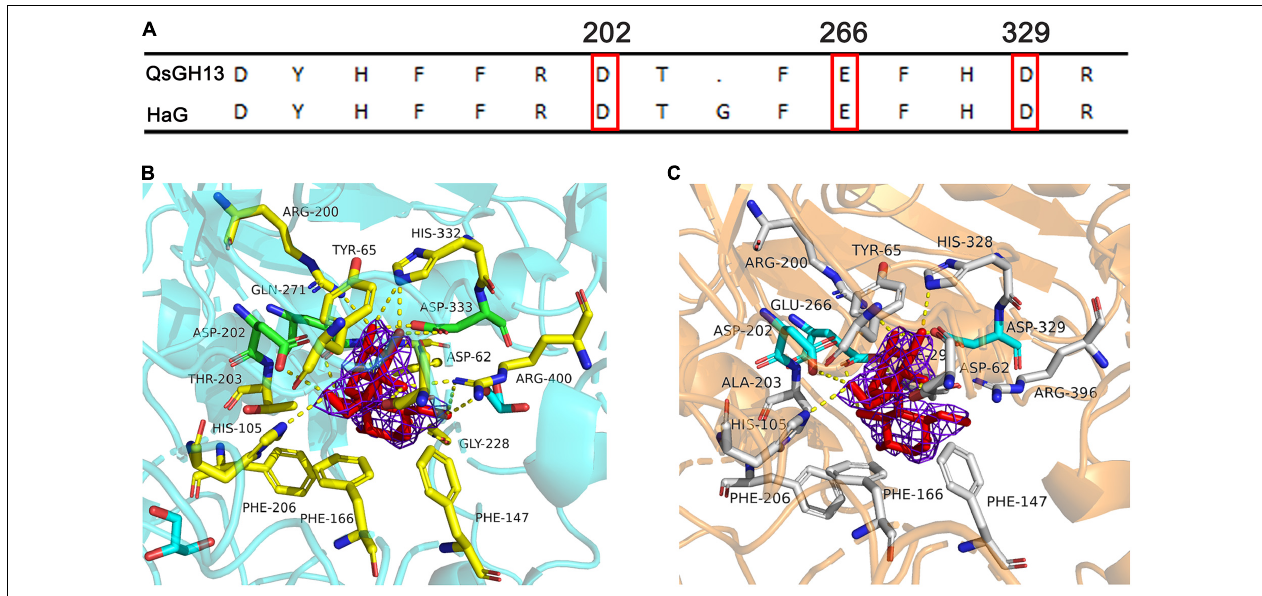
FIGURE 7 | Comparison of QsGH13 and HaG of amino acid residues near the active site. (A) Alignment of amino acid residues near the substrate recognition site. The red box indicates the catalytic site. (B) Fifteen amino acid residues around the catalytic sites of HaG. (C) Fourteen amino acid residues around the catalytic sites of QsGH13. Dashed lines indicate hydrogen bonding with the enzyme and substrate. The purple network represents the electron density cloud.